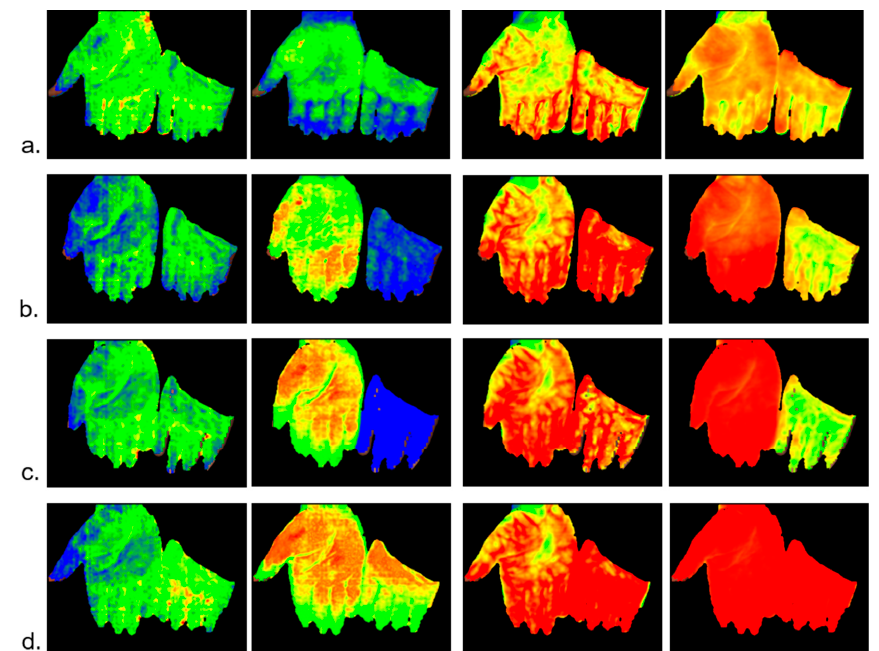
Figure 2. Survey images; color-coded parameters from left to right: vHb_1, xHbO 2 _1 (superficial), vHb_2, xHbO 2 _2 (deep); a: normal perfusion, b: venous occlusion, c: arterial occlusion, d: reperfusion after arterial occlusion. Color scales for vHb and xHbO 2 , as depicted in Figure 1.